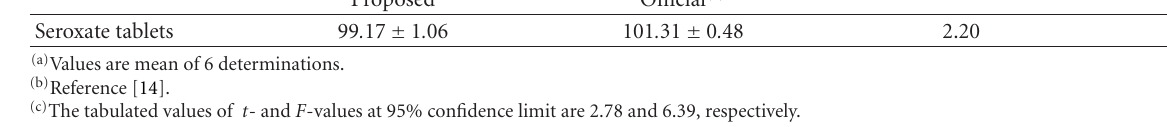
Table 5: Analysis of PRX-containing tablets by the proposed and the o ffi cial methods.